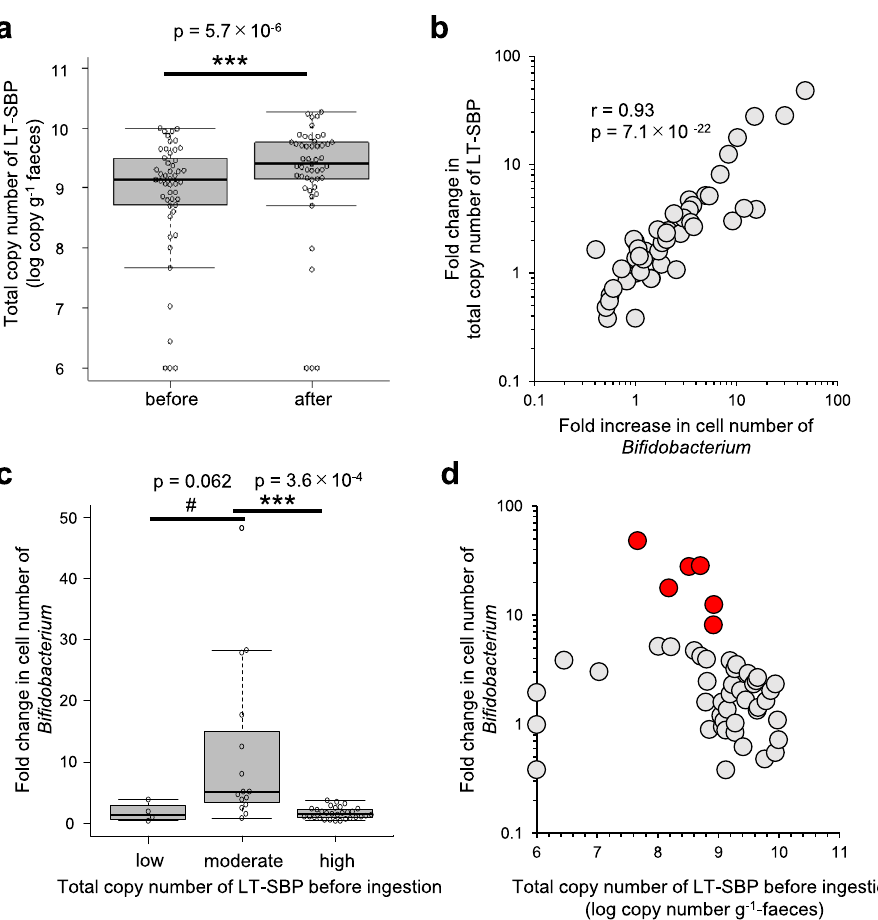
Fig. 5 Association between the fold change in Bi fi dobacterium abundance and the total copy number of the LT-SBPs in faecal samples after ingestion ( n = 49). a Total copy numbers of the LT-SBP genes in faecal samples were determined by real-time PCR and compared before and after lactulose ingestion (two-tailed paired t -test). b Scatter plot of the individual samples based on the fold change in total copy number of the LT-SBPs and faecal Bi fi dobacterium cell number after lactulose ingestion (Pearson correlation coef fi cient). c Varied response to lactulose ingestion among the subjects is associated with the faecal copy number of LT-SBP genes before the trial. #p refers to <0.1, *** p < 0.001, Tukey ’ s test. The box plots feature the median (centre line), upper and lower quartiles (box limits), 1.5× the interquartile range (whiskers), and outliers (points). d Scatter plot of individual samples based on the faecal copy number of LT-SBP genes before lactulose ingestion and the fold change in faecal Bi fi dobacterium cell number after lactulose ingestion. Red dots indicate subjects with a more than fi vefold increase of Bi fi dobacterium after lactulose